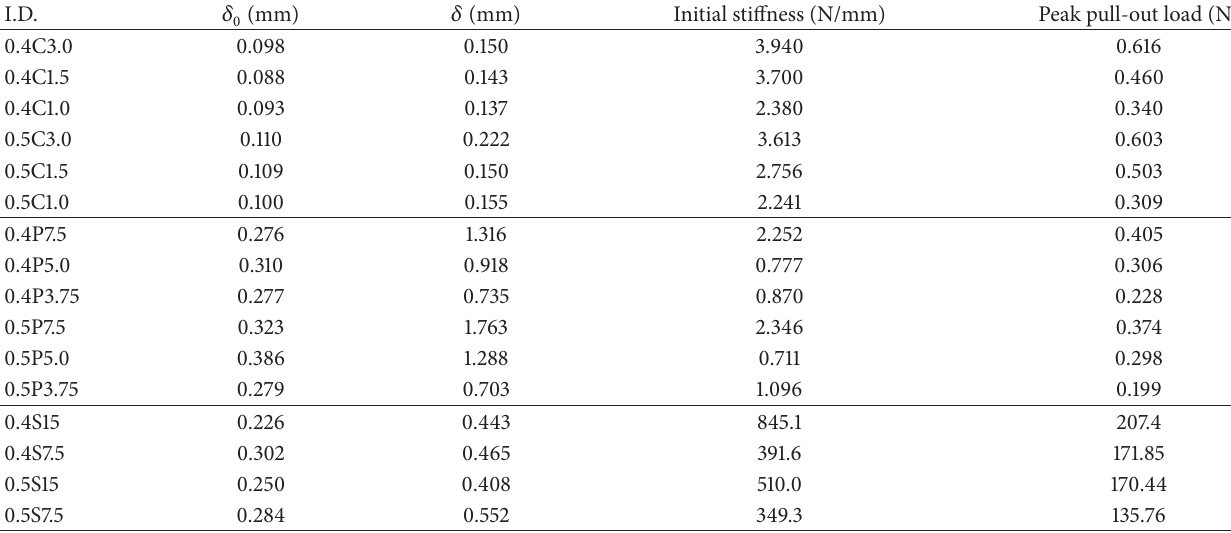
Table 5: Summary of test results.